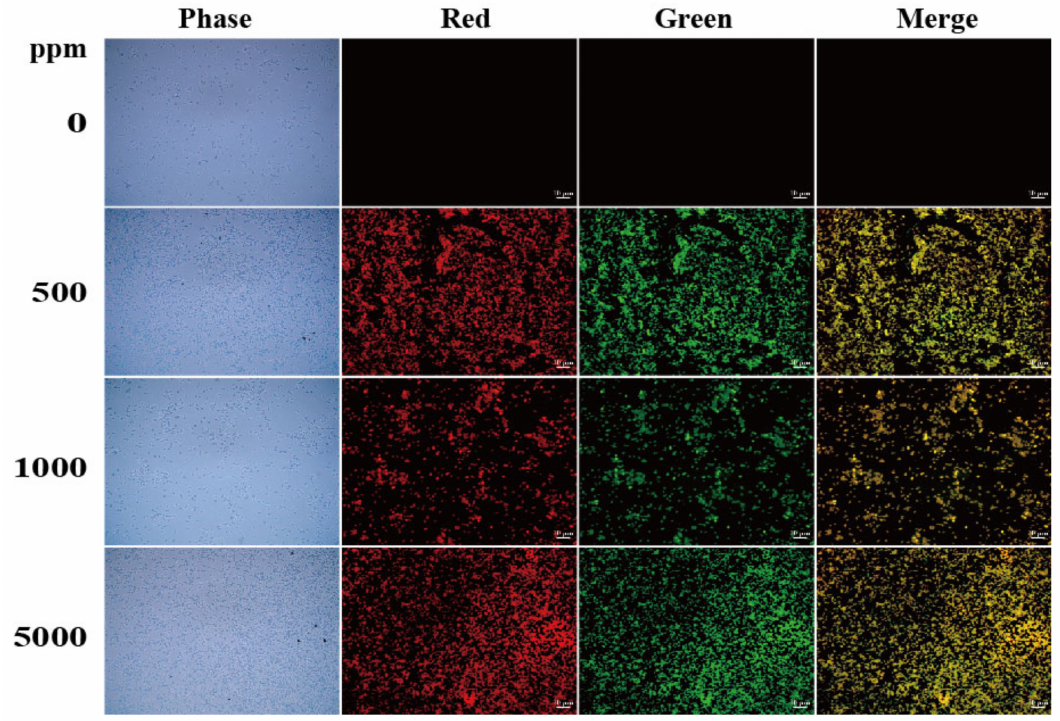
Figure 5. Microscopic fluorescence images of E . coli stained with N-CQDs. The cells were stained with N-CQDs at concentrations of 0, 500, 1000, and 5000 ppm. Control cells were assayed similarly without adding N-CQDs. Red fluorescence was detected under TRITC filter set, whereas green fluorescence was detected under FITC filter set. Scale bar represents 10 µ